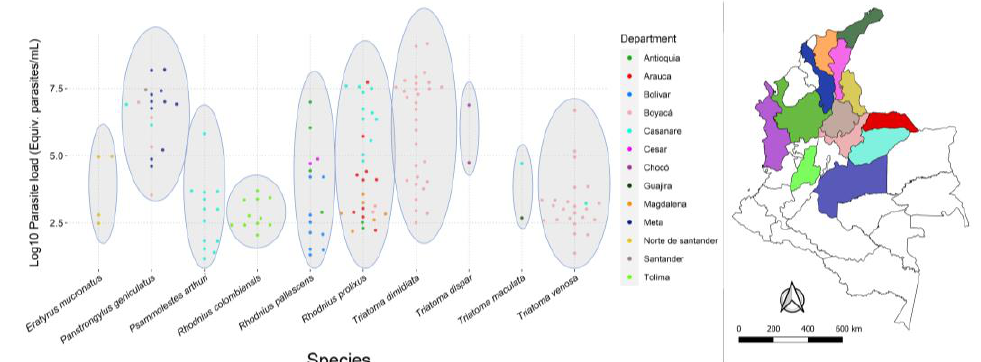
Figure 3. Boxplot of parasitic loads per species. Y -axis was transformed to Log10 scale for better visualization of the data. The number above the boxes is the number of samples per species. Aster- isks (***) represent statistically significant comparisons ( p < 0.0001). In blue, P. geniculatus with Ps. arthuri , R. colombiensis, and R. pallescens ; in black, T. dimidiata with Ps. arthuri , R. colombiensis , and R. pallescens ; and in red, T. venosa with P. geniculatus and T. dimidiata .